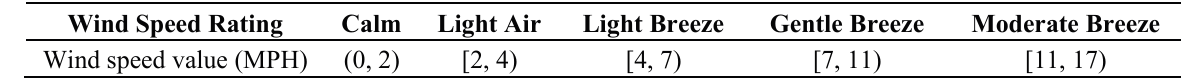
Table 4. Fuzzy classification of wind speed.